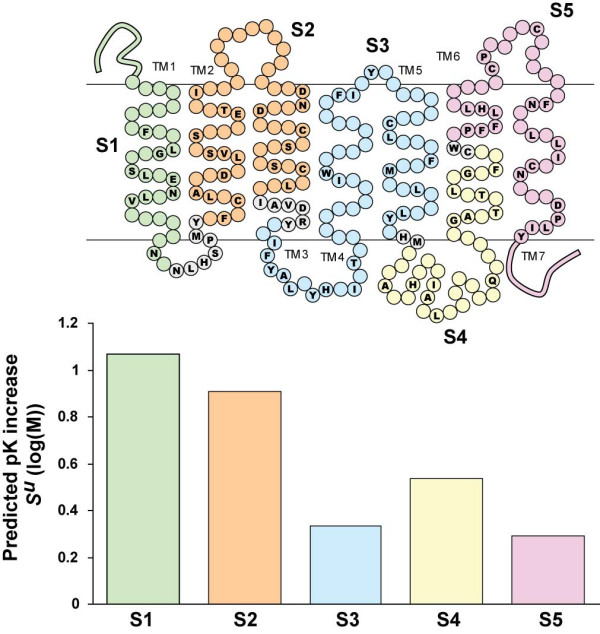
Increase in affinity of α-MSH predicted from the binary proteochemometric model. Shown is the increase in affinity SU (log(M)) for α-MSH afforded by swapping each of segments S1 – S5 in the MC4 receptor with the corresponding segment in the MC1 receptor as predicted from the binary proteochemometrics model.